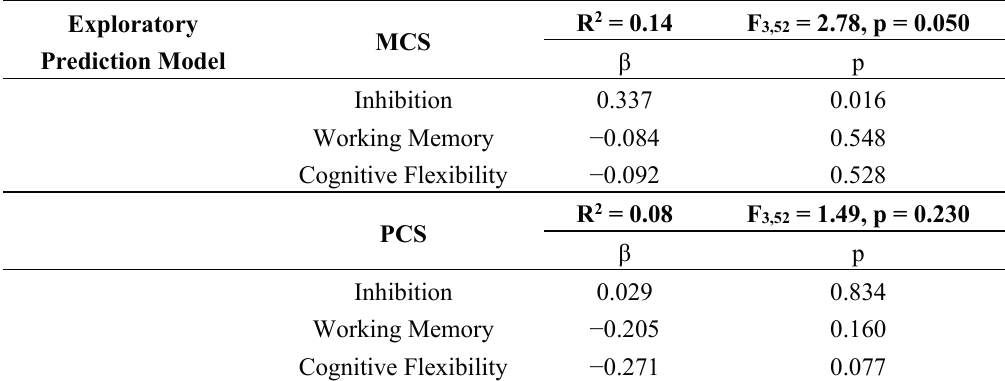
Table 3. Multiple regression models for the prediction of mental (MCS) and physical (PCS) HRQoL accrued by core executive functions (inhibition, working memory, and cognitive flexibility). Total R 2 explained, ANOVA results and standardized β coefficients with the level of significance are also